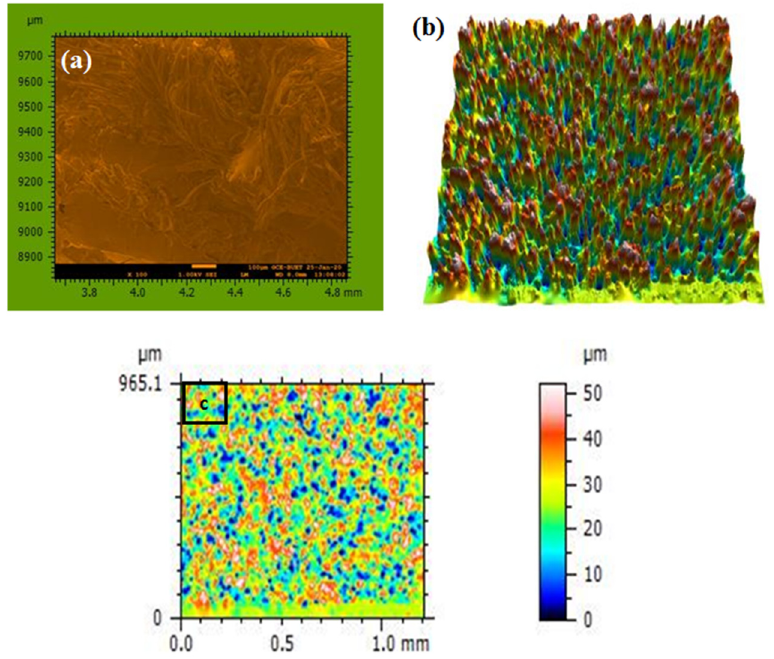
Figure 7. Surface morphology of JCJC spent tea leaf composites: ( a ) SEM pseudo-colored image, ( b ) 3D topology, and ( c ) surface topology.